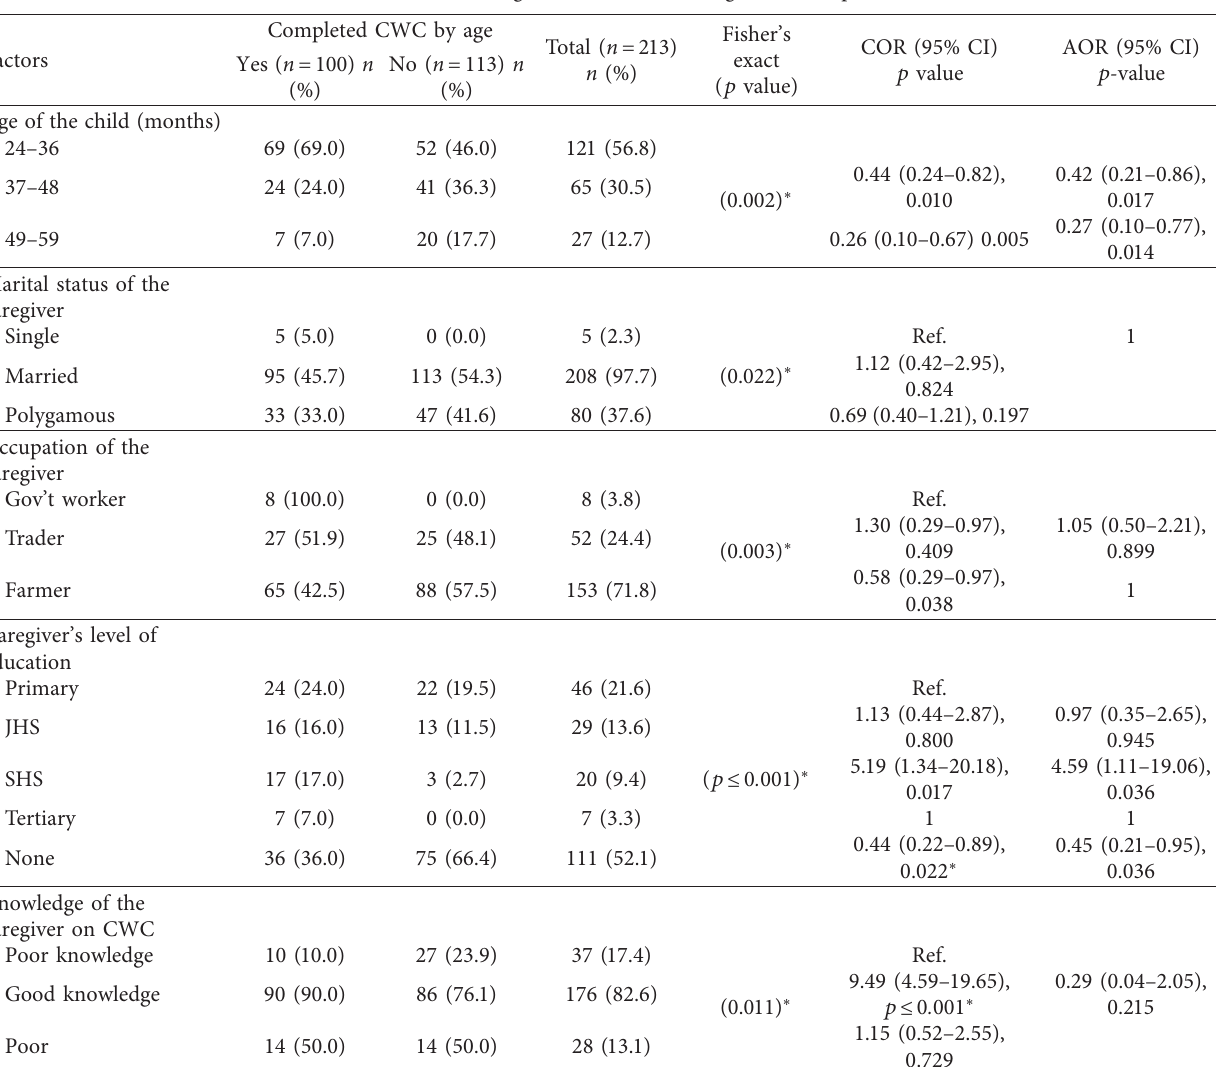
Table 3: Child and caregiver factors influencing CWC